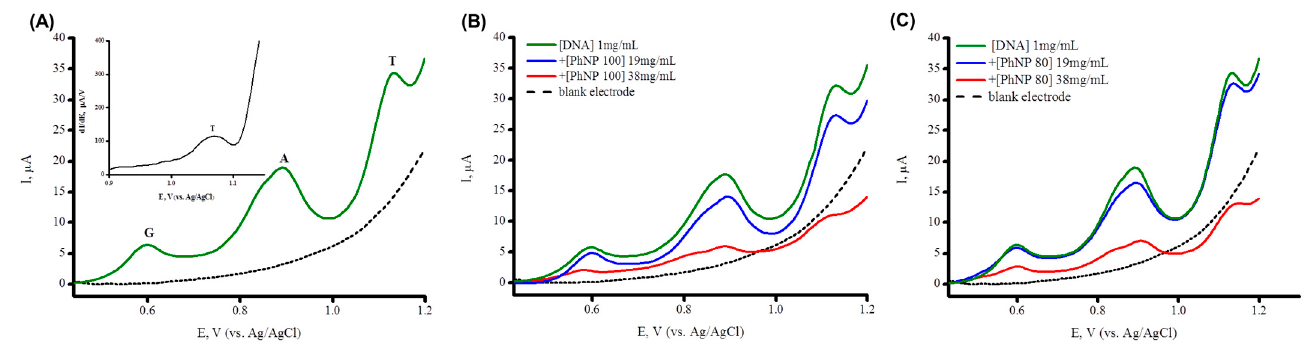
Figure 1. Differential pulse voltammograms of ( A ) dsDNA (1 mg/mL, green line) on SPE/CNT (dotted line is blank electrod) electrodes, ( B ) in the presence of PhNP100 (19 and 38 mg/mL), ( C ) PhNP80 (19 and 38 mg/mL). Insert: electrochemical oxidation of 100 μ M thymidine-5’-triphosphate on an SPE/CNT electrode. First derivatives of the DPV raw data were used for calculating the intensity of the corresponding peak values.